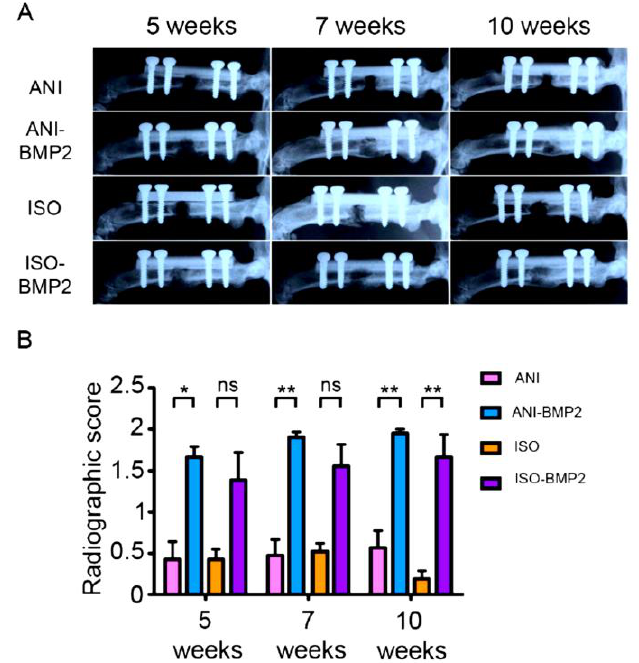
Figure 4. Radiographic follow-up of the reparative process. ( A ) Single plane radiographs were taken at 5, 7, and 10 weeks post-surgery. Representative samples are depicted for each group; ( B ) The healing was scored with a simplified RUST scoring system. *, p < 0.05; **, p < 0.01; ns, non-significant by Kruskal–Wallis test ( p = 0.0001) followed by post-hoc Dunnett’s multiple comparisons test.